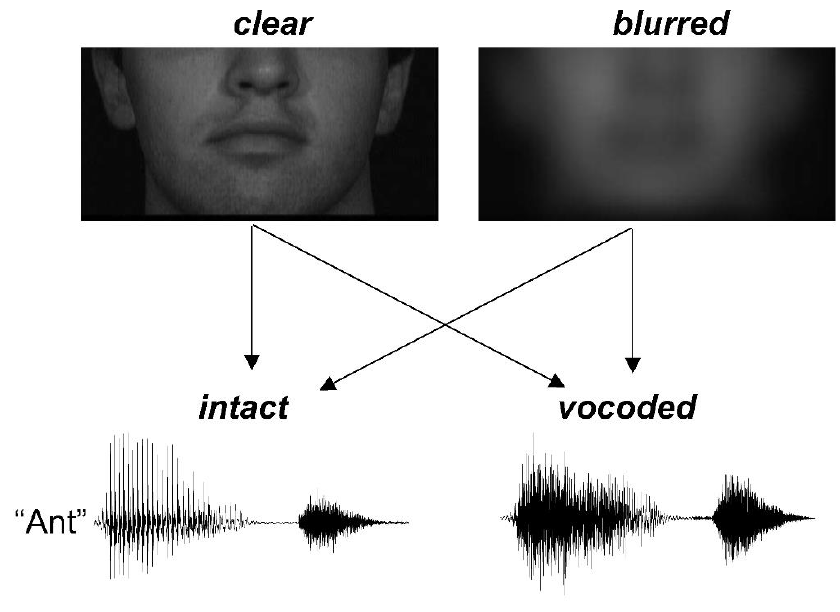
Figure 1. Depiction of stimulus design.